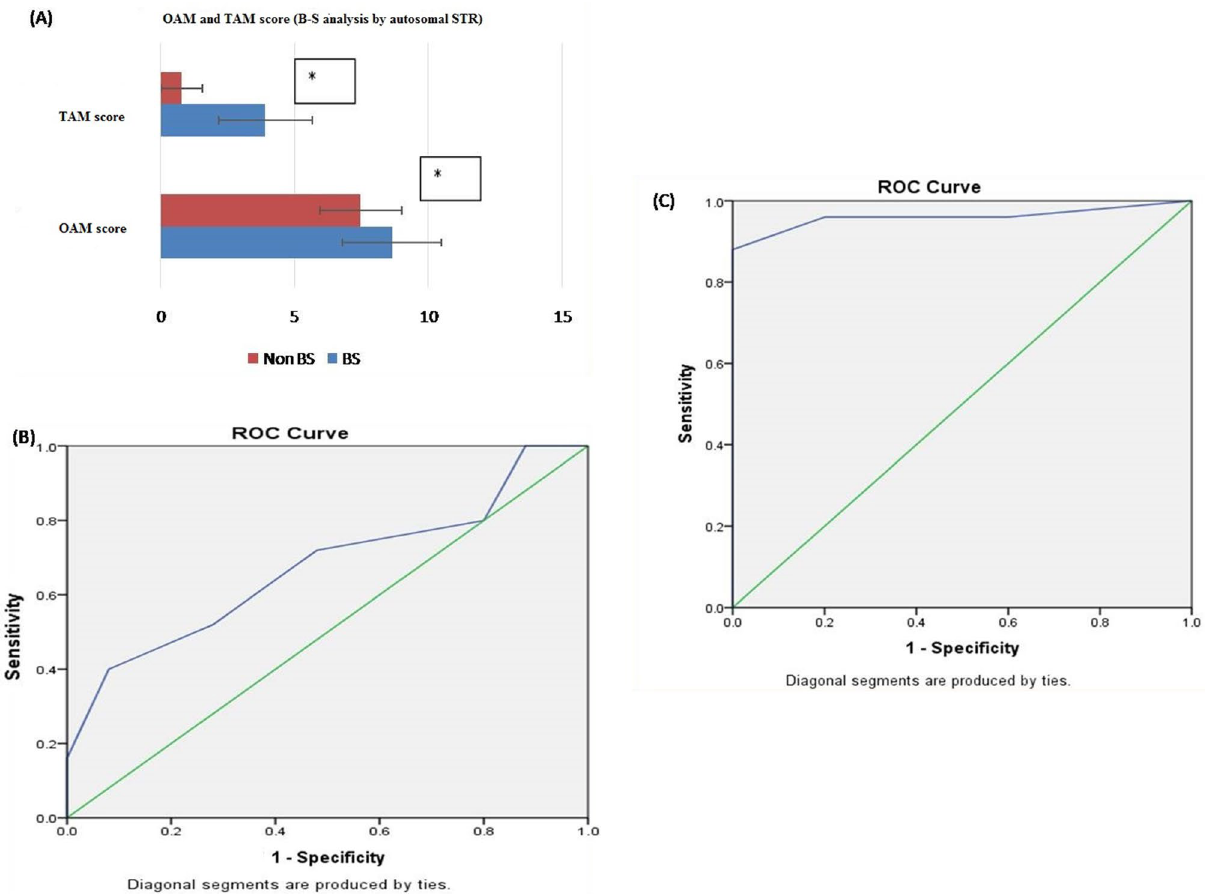
Figure 1. ( A ) OAM and TAM score for B-S analysis by autosomal STR. based on OAM and TAM score, statistically significant difference between B-S (related) and non-B-S (unrelated) groups was seen with Autosomal STR. The average TAM score for the B-S group is 3.92 ± 1.754 (SD), and for the non-B-S group average, TAM is 0.80 ± 0.764 (SD). Whereas the average OAM score for the B-S group is 8.64 ± 1.846 (SD) and for the non-B-S group is 7.48 ± 1.531 (SD). Figure 1 ( A–C ) obtained from SPSSsoftware version 22.0 (Available for download at: https:// www. ibm. com/ suppo rt/ pages/ downl oading- ibm- spss- stati stics- 22). *Statistically significant difference ( p < 0.05). ( B ) ROC curve (AUC 67%), showing the performance of OAM score as a screening test for B-S pairs by autosomal STR. ( C ) ROC curve (AUC 96%), showing the performance of TAM score as a screening test for B-S pairs by autosomal STR.